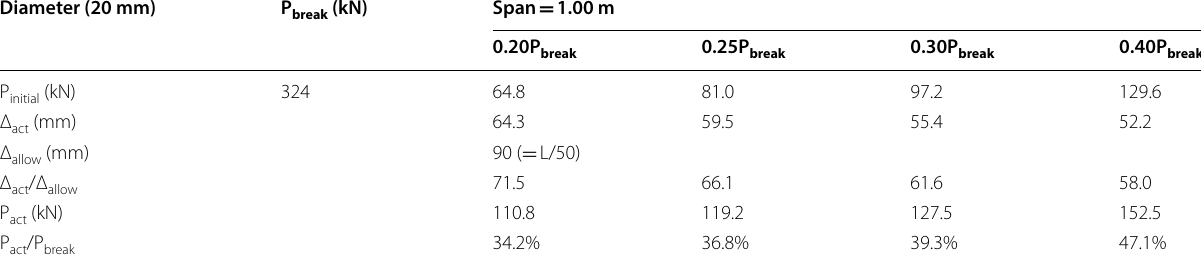
1.0 m Test result. =